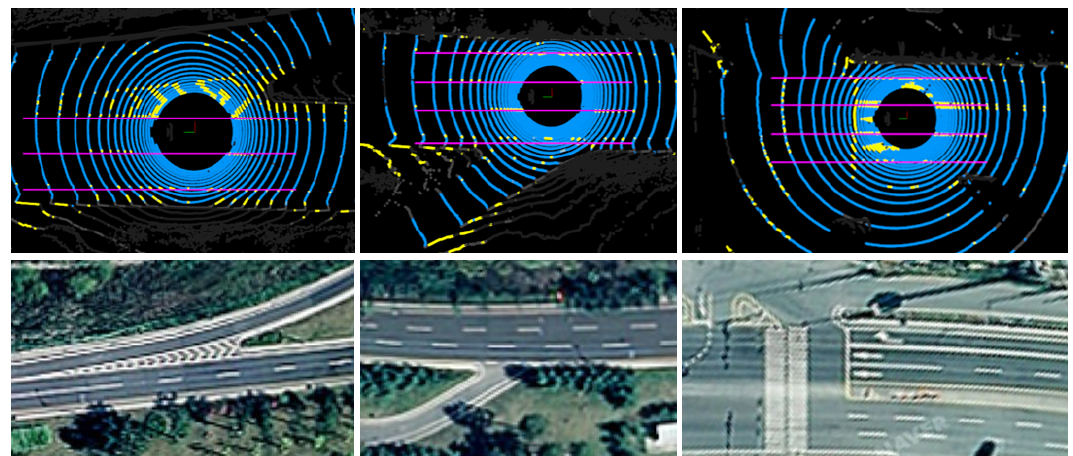
Figure 3. Three different examples of drivable region categorization and road line detection with two or three lanes on the road in the presence of ramps on the right or left ( left , middle ) and at the junction ( right ). The figures below show the satellite images of the same scene for better understanding.